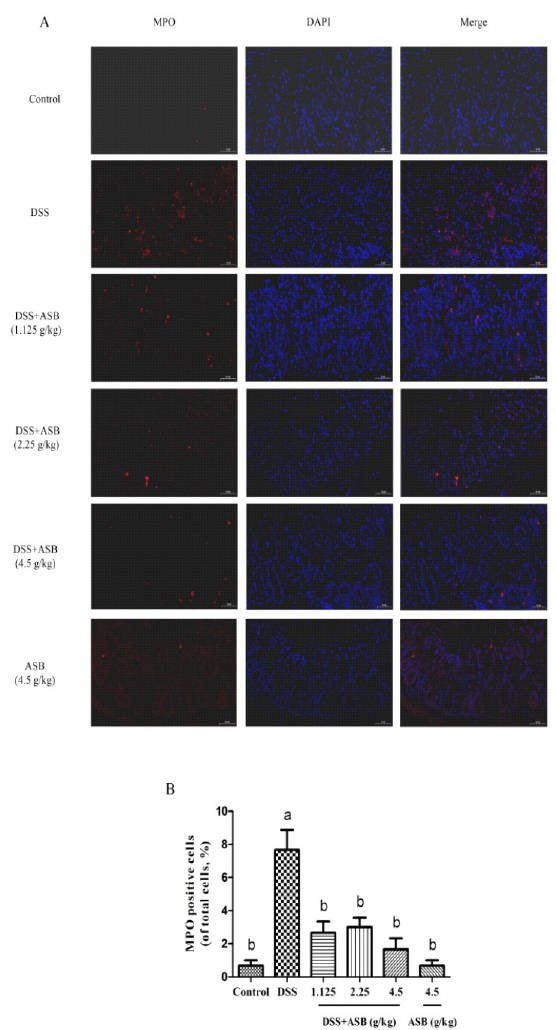
Figure 4. Effect of ASB on the levels of an inflammatory factor in the colon. Expression of MPO in colonic tissue was assessed by immunofluorescence (scale bar: 50 µm) ( A ) and MPO‐positive cells quantification ( B ). Results were expressed as mean ± SD ( n = 3). The expression levels of MPO marked by the same letter are not significantly different. Significance is represented as p < 0.05.